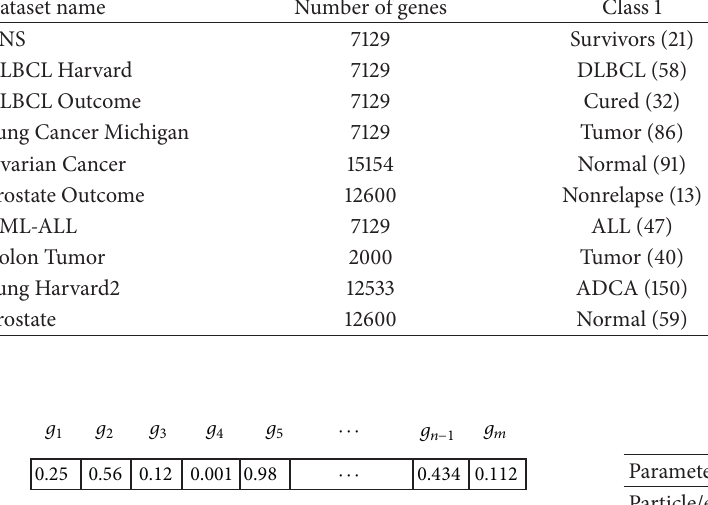
Figure 2: Candidate solution representation.